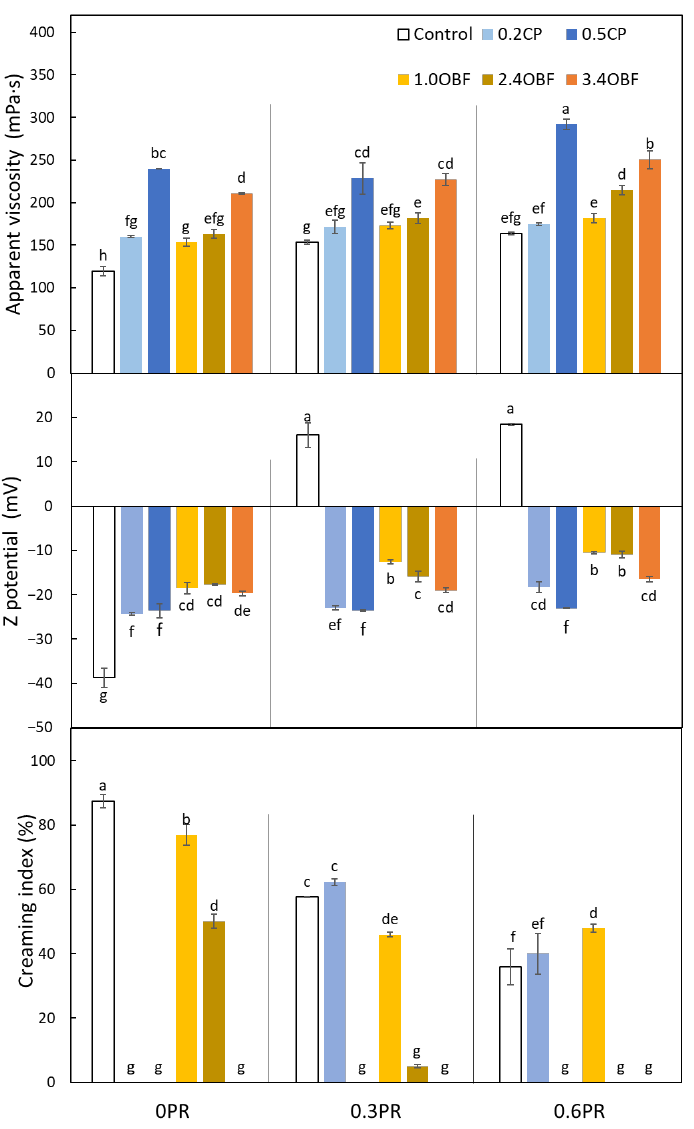
Figure 1. Characteristics of oil-in-water emulsions prepared without any source of pectins or proteins (control), containing purified commercial pectins (0.2CP and 0.5CP for 0.2 and 0.5% w / w , respectively) or an orange by-product flour (1.0OBF, 2.4OBF, and 3.4OBF for 0.95, 2.38, and 3.40% w / w , respectively) combined with proteins (0.3PR and 0.6PR for 0.3 and 0.6% w / w , respectively) or without them (0PR). Different letters indicate significant differences ( p < 0.05).